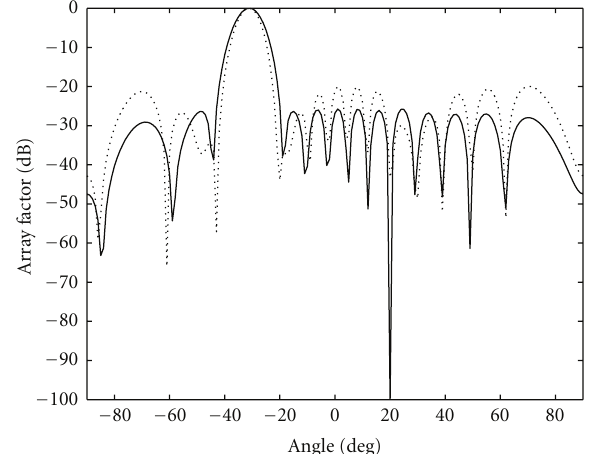
Figure 8: Radiation pattern of 20 element linear broadside array with null at − 42 ◦ and 18 ◦ and SLL of −